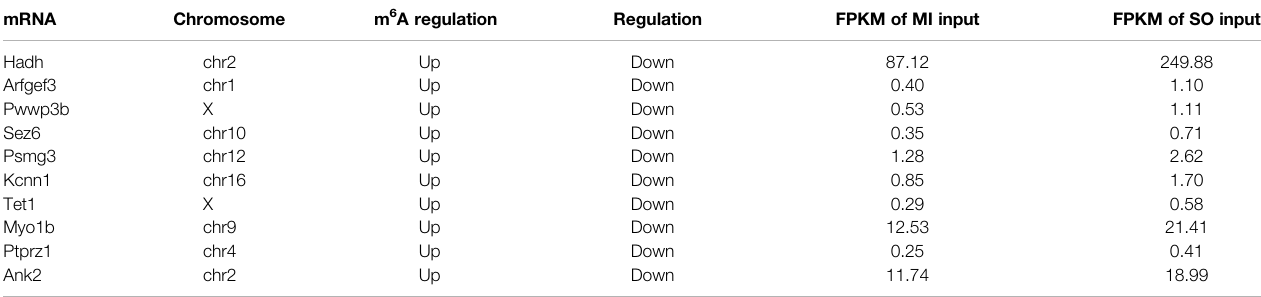
TABLE 3 | Top 10 hypermethylated and downregulated mRNAs. mRNA